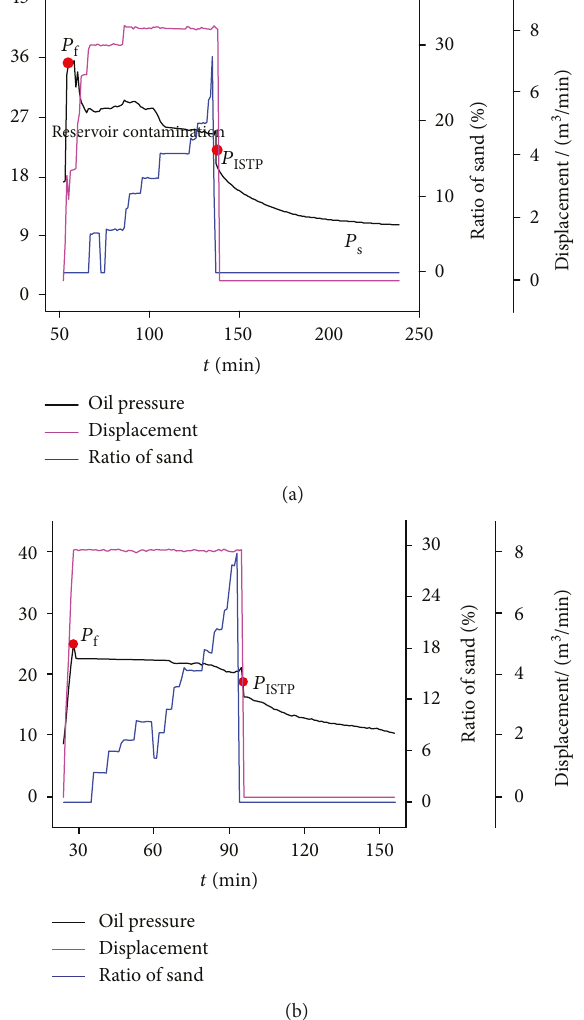
Figure 6: (a) The abnormal fracturing construction curves. (b) The normal fracturing construction